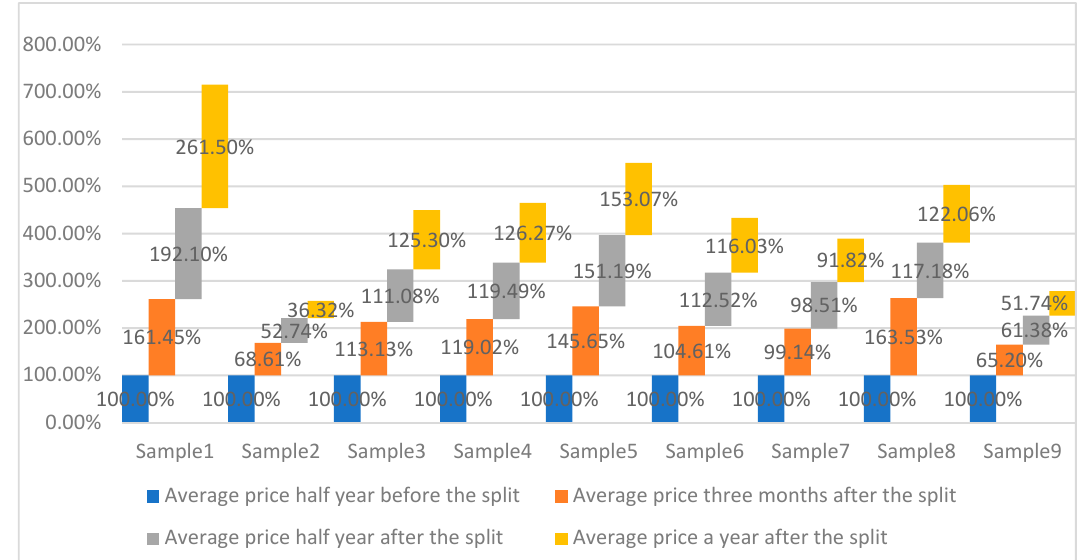
Figure 7. Average stock price for the different periods.